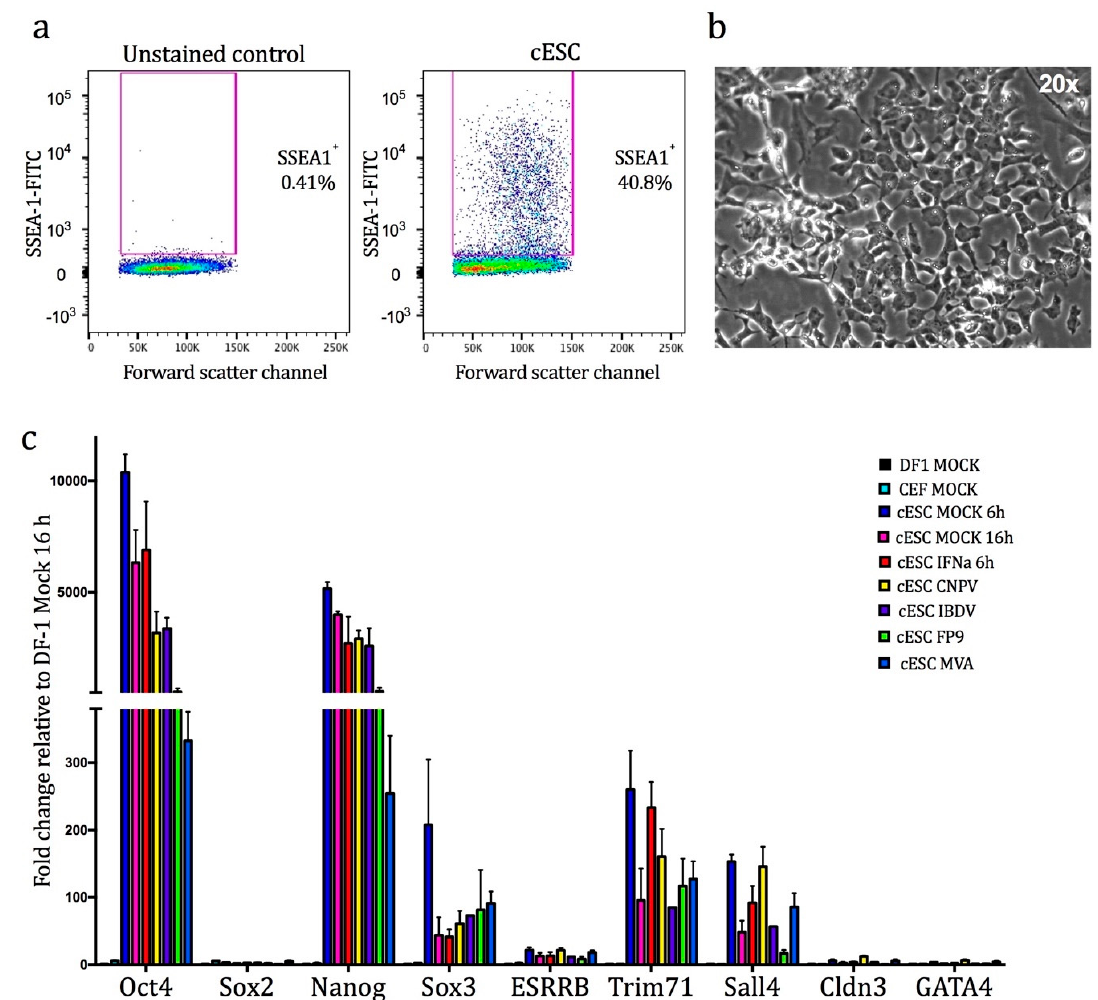
Figure 1. ( a ) Forward scatter plotted versus anti-stage specific embryonic antigen SSEA1–fluorescein isothiocyanate (FITC) fluorescence for cESC showing an identifiable SSEA1–positive cESC sub-population. Left: Unstained control. ( b ) Phase contrast microscopy image of chicken embryonic stem cells (cESC) culture (magnification 20×; Evos Fl microscope). ( c ) Fold change in expression by qRT-PCR of cESC pluripotency markers during viral infection and stimulation with recombinant chIFN- α . Values are normalised against DF-1 mock-infected cells. Error bars represent SEM ( n =